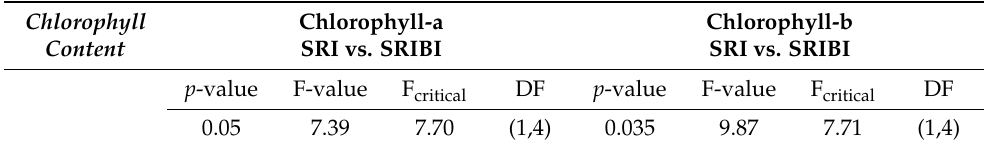
Figure 13. Comparison of chlorophyll-b content between the different treatments ( Left : 2017; Right : 2018). Table 11. Parameters from ANOVA statistical analysis for chlorophyll content comparison.